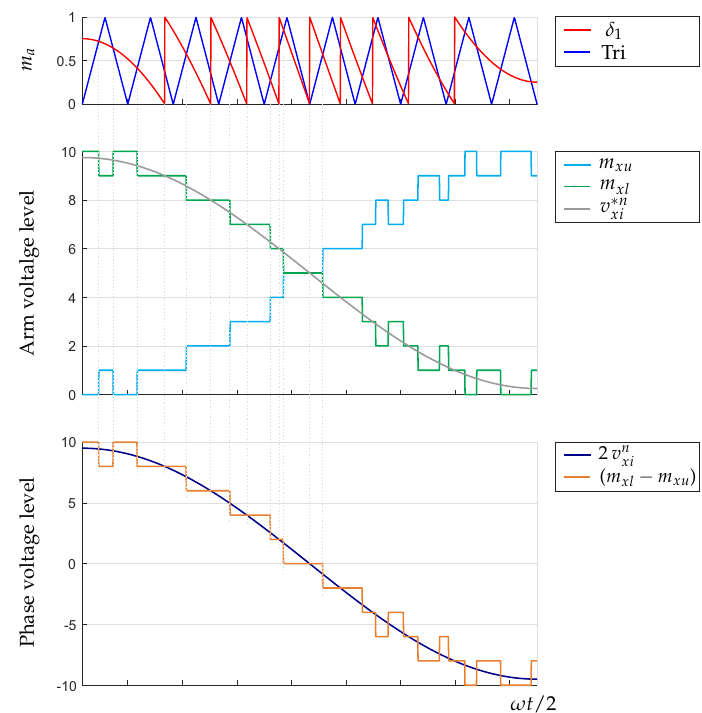
Figure 4. Operational principles of the conventional SAM.